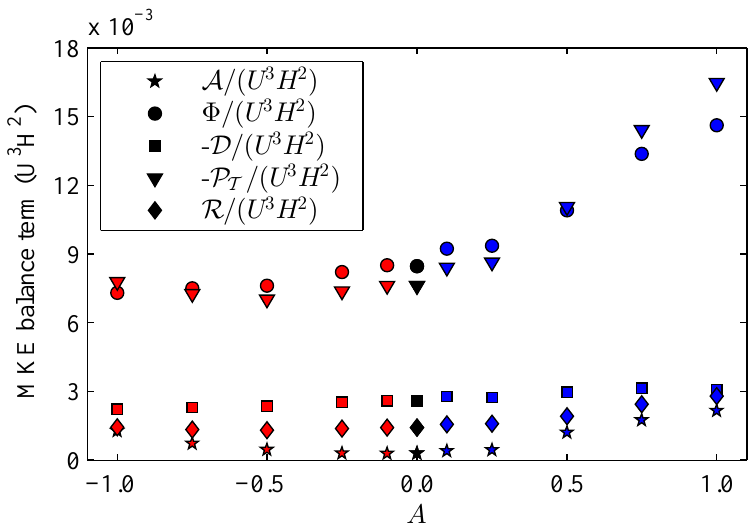
Figure 10. The contribution of MKE in the turbine region due to each term in the MKE balance (Equations (8)–(11)) is shown as a function of the forcing parameter A